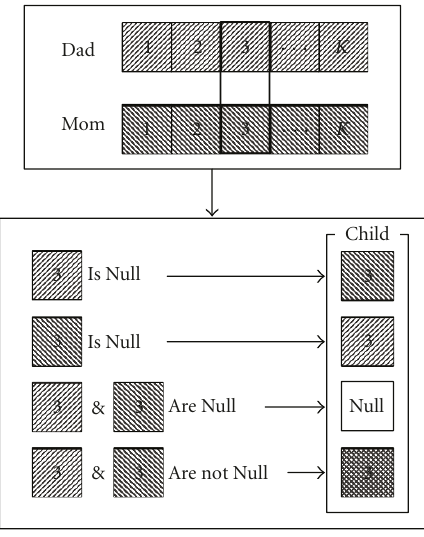
Figure 2: One child crossover